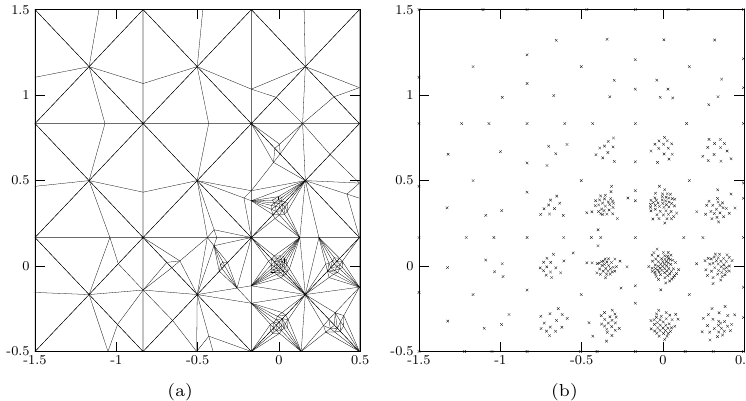
Figure 2. The illustration of minimization results of the Rastrigin function: simplicial covering of the feasible region after termination with Δ = 0 . 05 d and points where function values were computed after termination with Δ = 0 . 03 d